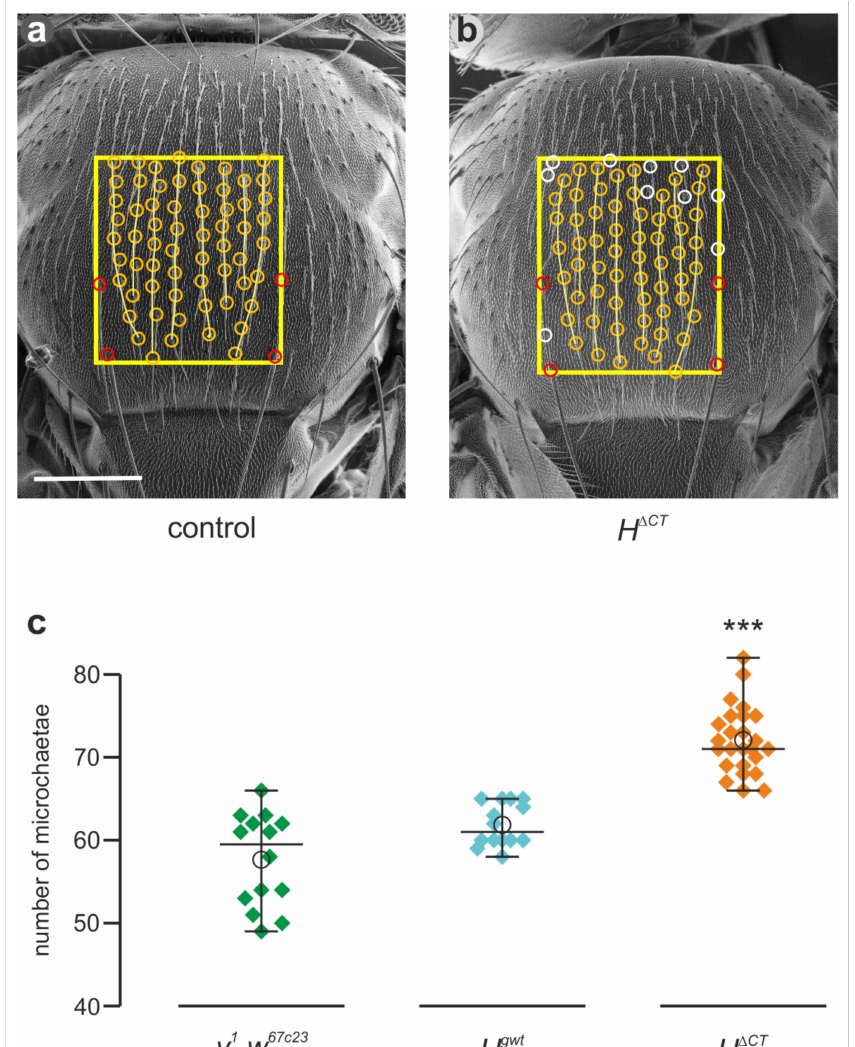
Figure 2. Gain of function bristle phenotypes in H ∆ CT homozygotes. ( a , b ) Scanning electron mi- crographs of typical thoraces from y 1 w 67c23 (control) and from H ∆ CT female flies, respectively. Microchaetae (encircled in yellow) were counted in the outlined area between intrascutal suture and posterior dorsocentral macrochaetae (encircled in red). Microchaetae form eight regular rows (yellow lines) in the control y 1 w 67c23 flies ( a ), whereas they occur at irregular positions (encircled in white) and are more densely spaced in H ∆ CT ( b ). Scale bar, 200 µ m in ( a , b ). ( c ) Microchaetae counts from y 1 w 67c23 and H gwt for control ( n = 14) and from H ∆ CT ( n = 25) were plotted. Center lines show the medians, empty circles the means; whiskers extend 1.5 times the interquartile range from the 25th and 75th percentiles, respectively. Significance was determined with ANOVA two-tailed Dunnett’s test for multiple comparisons; significant differences are observed between both the controls and H ∆ CT (*** p ≤